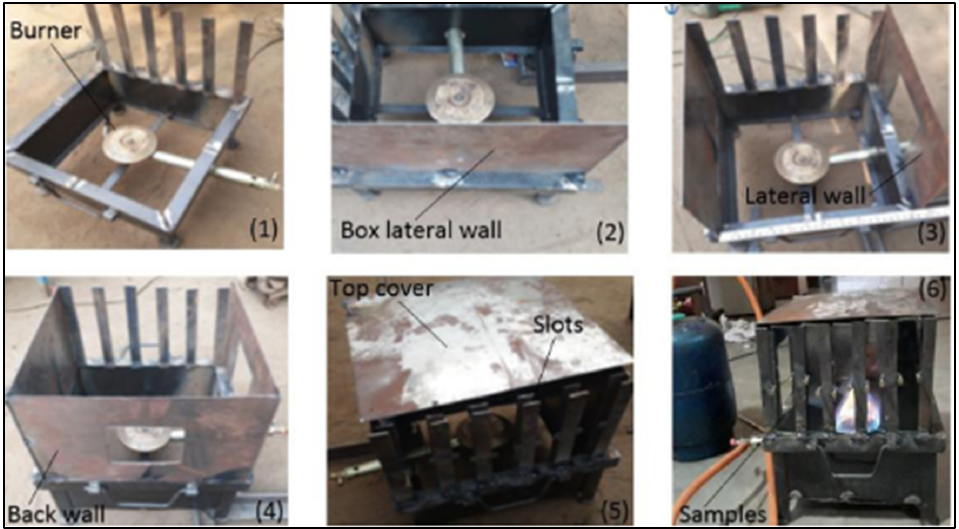
Figure 15. Specialized fire test setup (1) burner, (2) box lateral wall, (3) lateral wall, (4) black wall, (5) top cover and slots. and (6) samples.